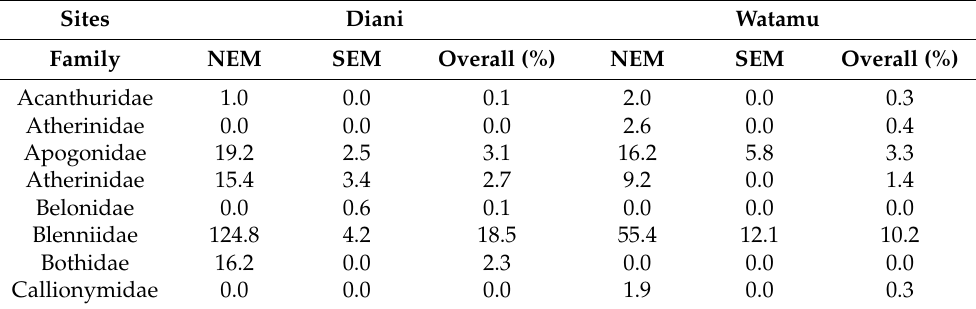
Figure 3. Seasonal variation in ( A ) zooplankton, ( B ) fish eggs and ( C ) fish larvae abundance in Watamu and Diani, Kenya in the years 2019–2020 ( ± SE). Fish eggs followed a similar pattern with zooplankton density. The highest fish egg densities recorded was 40 no · m − 3 during the NEM season Watamu, while the lowest was 0.3 no · m − 3 at the same site (Figure 3B). Fish egg abundance in Watamu was higher than Diani but not statistically significant ( p = 0.06). Table 1. Total larval abundance (no · 100 − 3 ) during the northeast and southeast monsoon season and overall percentage contribution in Diani and